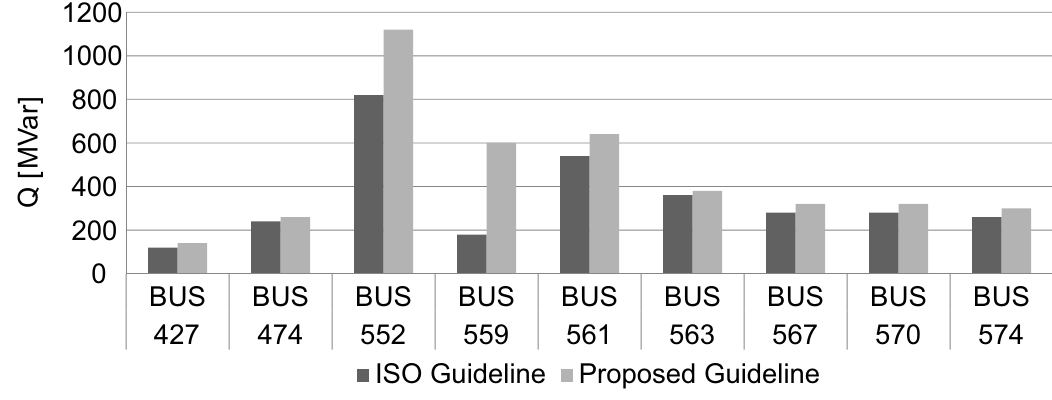
Figure 7. Reactive power margin for selected load buses.